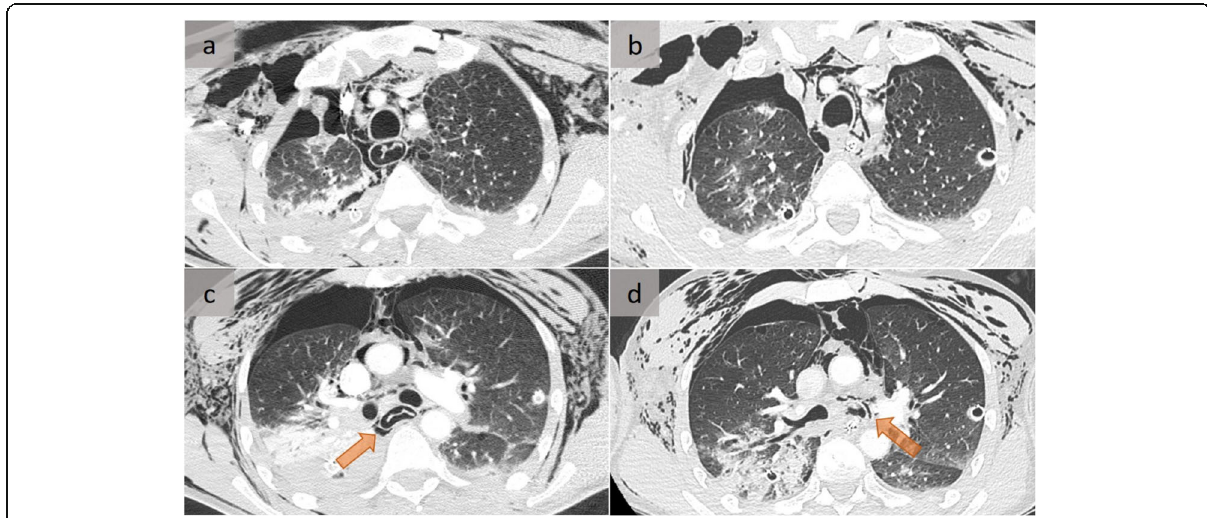
Fig. 2 Traumatic pneumomediastinum. A patient who experienced high-velocity trauma while skiing with subcutaneous emphysema, bilateral pneumothorax, and pneumomediastinum. Note the air within the esophageal wall that subsequently resolved 1 day later, at the level of the supra-aortic vessels ( a , b ) and below the carina ( c , d ) (orange arrows). This appearance mimics the presence of an intramural esophageal dissection that mandates the need to exclude an esophageal injury, which was the case here. Repeated bronchoscopy performed due to persistent air leak through the right drainage tube revealed multi-segmental right bronchial fistulae